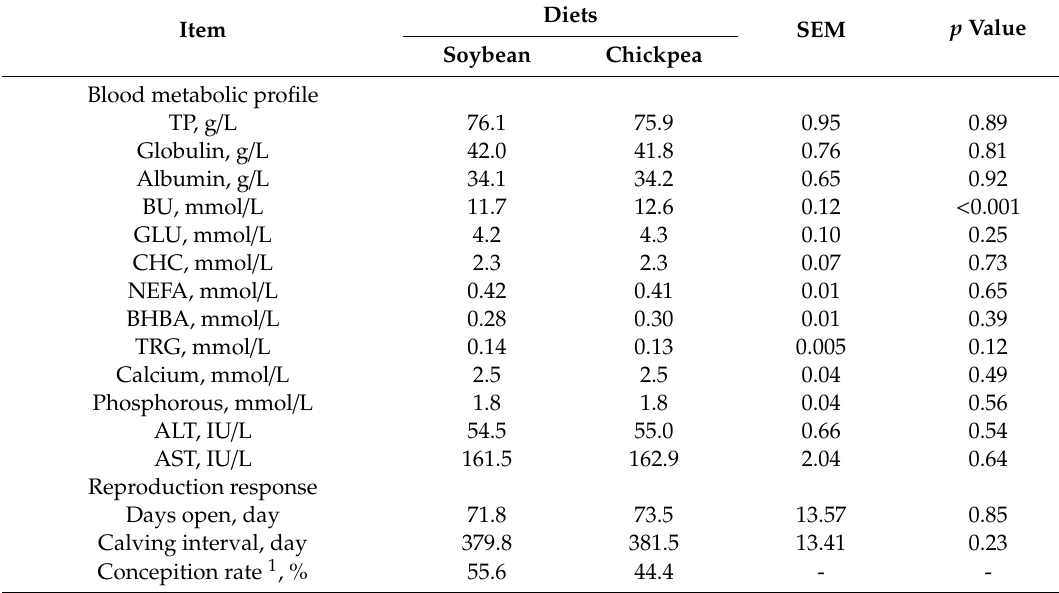
Table 6. Blood metabolic profile and reproduction response (Least Square Means) of bu ff aloes fed soybean meal and cickpeas meal as main protein sources. Item